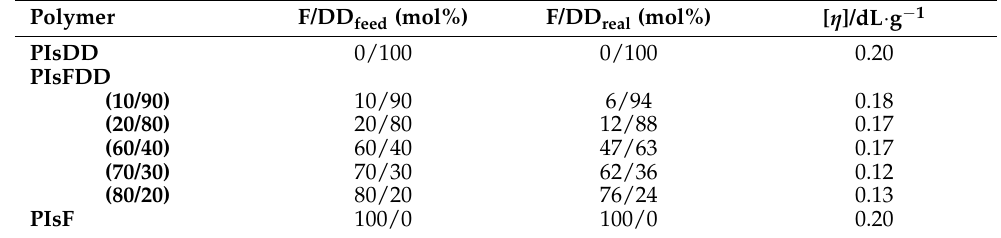
Table 1. Feed (F/DD feed ) and real (F/DD real ) molar ratios of furan and 1,12–dodecanedioate moieties.